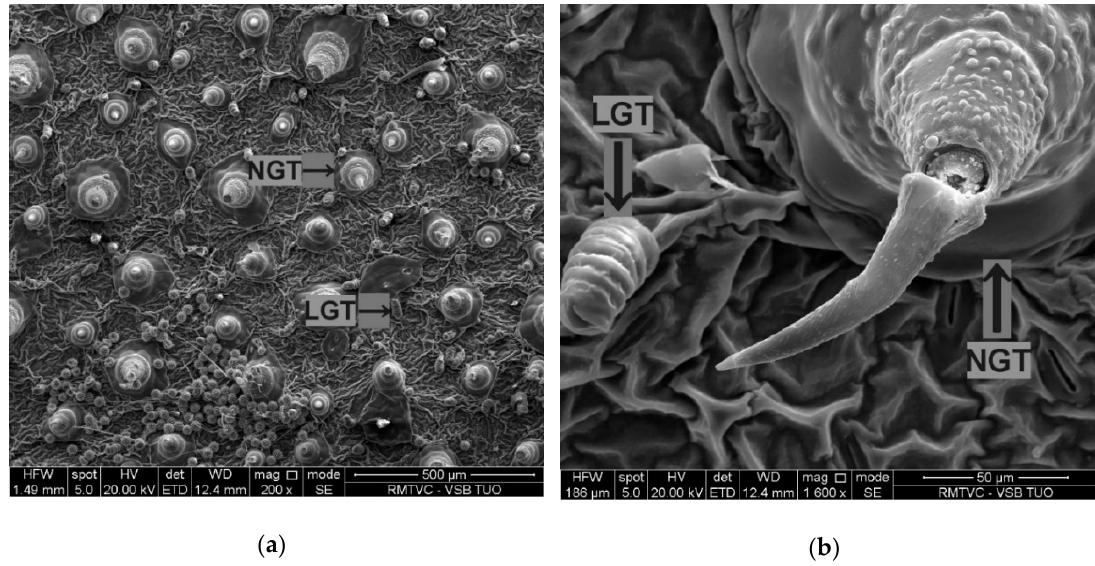
Figure4. Representativescanningelectronimageofsunflowerleafsurfacewithnon-glandulartrichomes Figure 4. Representative scanning electron image of sunflower leaf surface with non ‐ glandular (NGTs) and linear glandular trichomes (LGTs) in both NPs-treated variants and the control—( a ) leaf trichomes (NGTs) and linear glandular trichomes (LGTs) in both NPs ‐ treated variants and the surface, ( b ) trichome detail. control—( a ) leaf surface, ( b ) trichome detail. Table 4. Distribution of the three trichomes on leaves collected during flower-bud formation after two TiO 2 -NP and ZnO-NPs foliar applications compared to NPs-free controls (N—number of analysed trichomes, NGTs—non-glandular trichomes, LGTs—linear glandular trichomes, CGT—capitate glandular